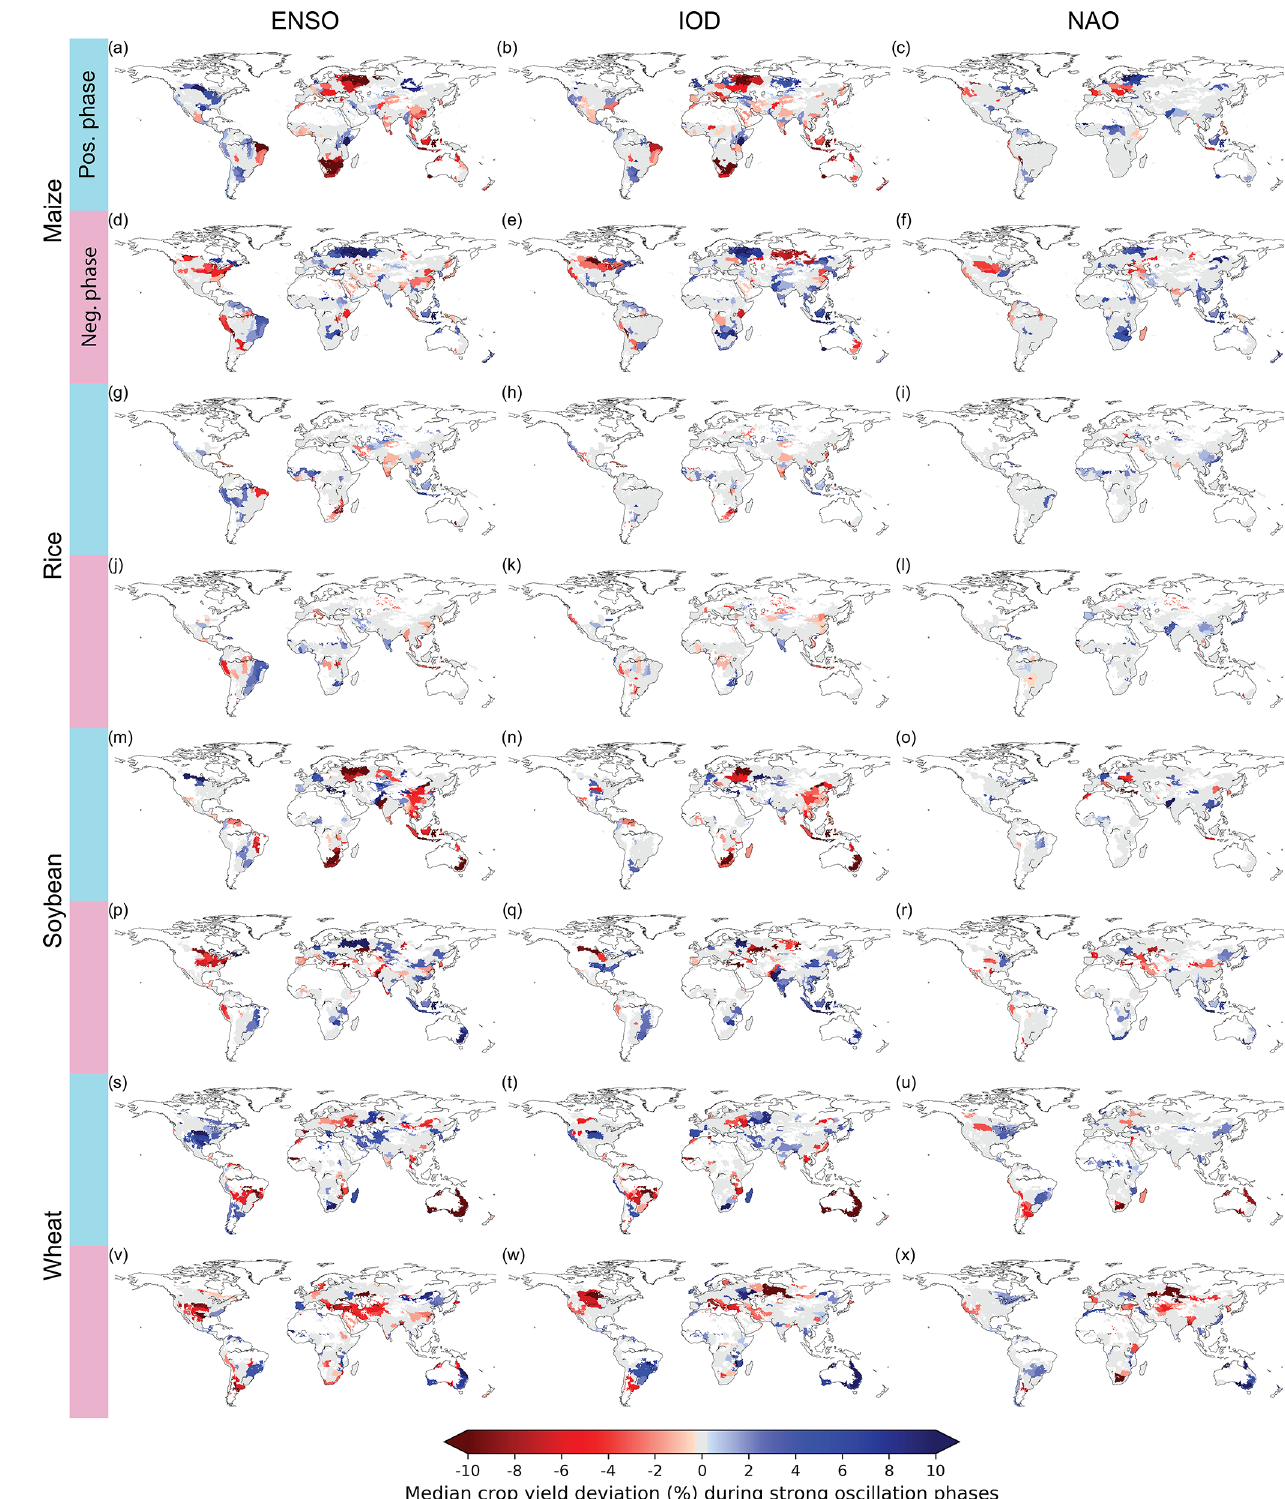
Figure 2. Actual maize (a–f) , rice (g–l) , soybean (m–r) , and wheat (s–x) yield anomalies during strong phases of ENSO, IOD, and NAO at the FPU scale. The anomaly values are derived from a sample including crop yield data from all GGCMs that simulate the crop in question with the AgMERRA climate input. Statistically insignificant ( p > 0 . 1) anomaly values are marked as zero (grey). White denotes that the crop in question is not produced in that area. Patterns are discussed in Sect. 3.1 and